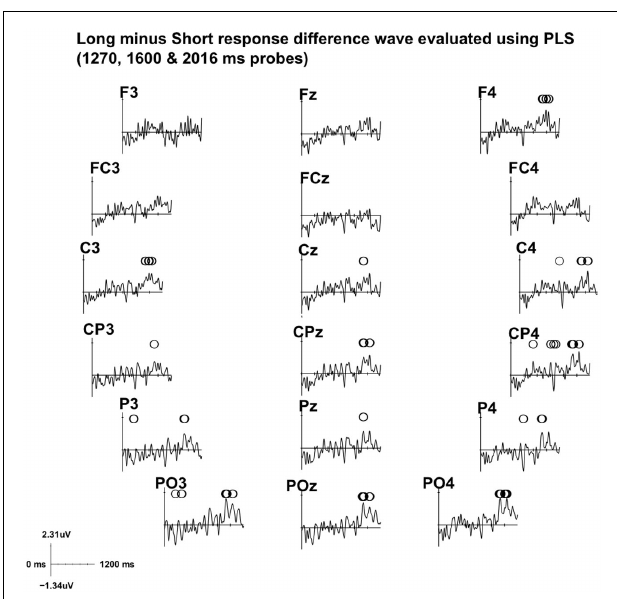
FIGURE 6 | Electrode salience of the ERP difference between “long” and “short” responses from a subset of data (intermediate probes 1270, 1600, and 2016ms) is illustrated for the fronto-central and parieto-central electrodes. Statistical significance and stability of the differences between the two conditions at each time point was obtained by partial least square (PLS) analyses. Circles indicate statistical significance ( p < 0.05). A positive salience difference indicates less negative amplitude in the ERP of the “long” responses.The time axis is segmented by 200ms tick marks, and positive amplitude is plotted upward.